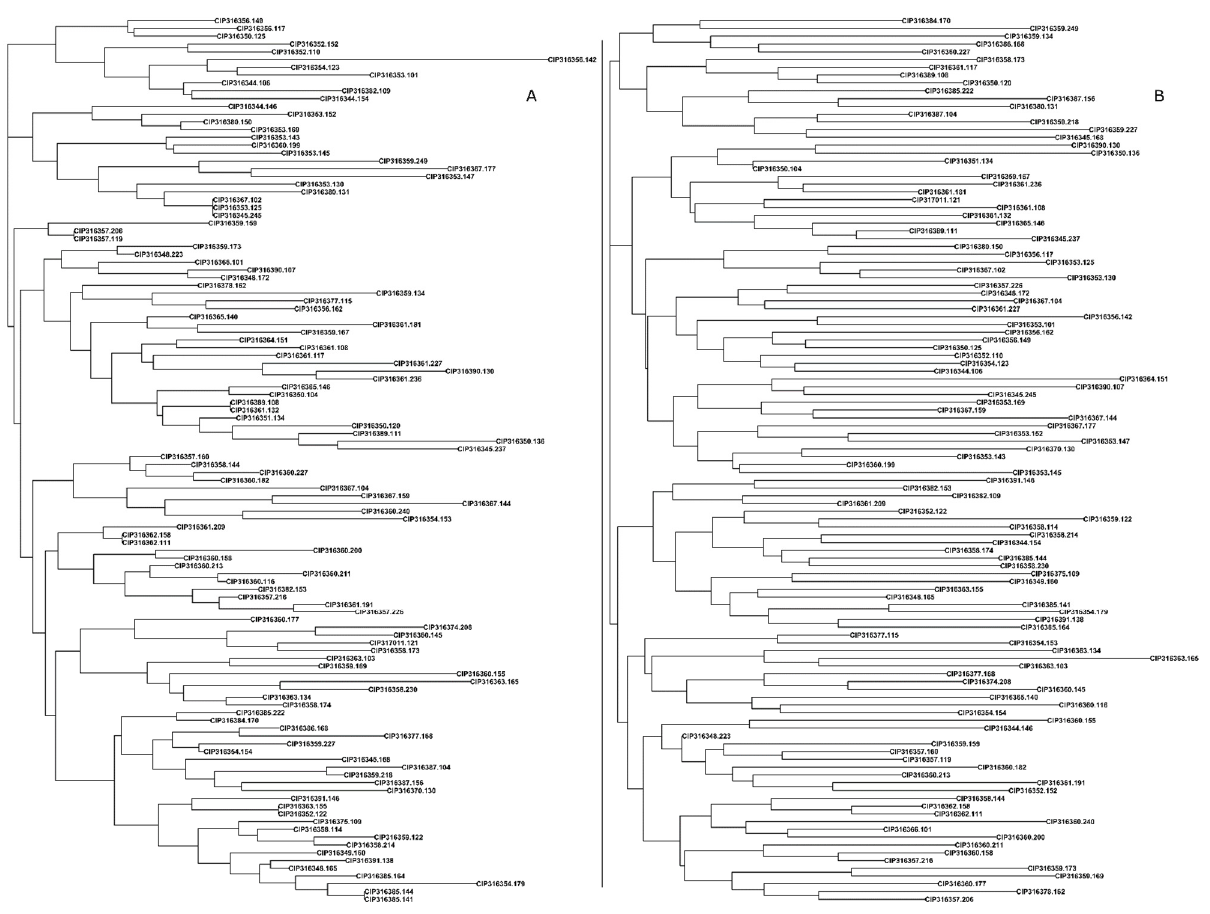
Figure 5. Neighbor joining tree constructed with 114 clones from La Molina greenhouse and 20 QC KASP markers with diploid ( A ) and tetraploid ( B ) calls. Elements before the dot sign represent the family identification.